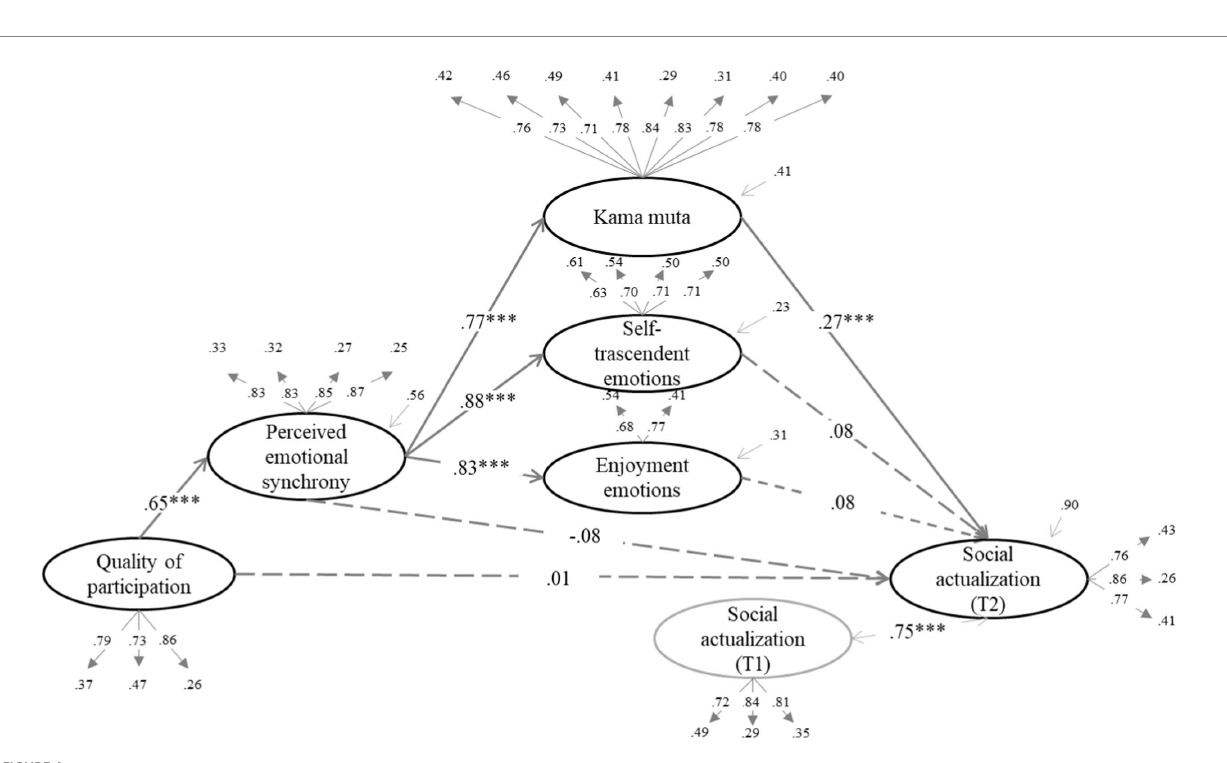
FIGURE 4 Perceived emotional synchrony and emotions as mediators of the effect of quality of participation on social actualization controlling for pre-participation scores. Model fit: χ 2 = (404, 313) = 816.599, p < 0.001, CFI = 0.925, TLI = 0.916, RMSEA = 0.063. SRMR = 0.056.